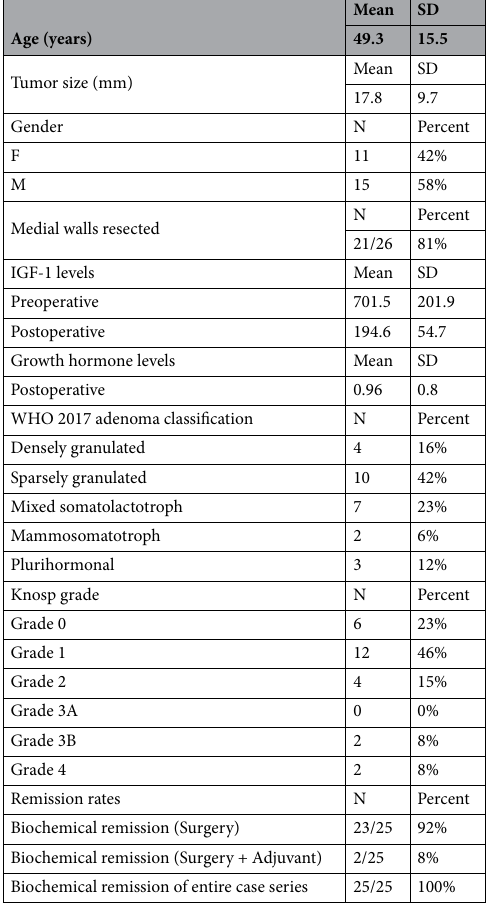
and continuous variables are reported as mean ± standard